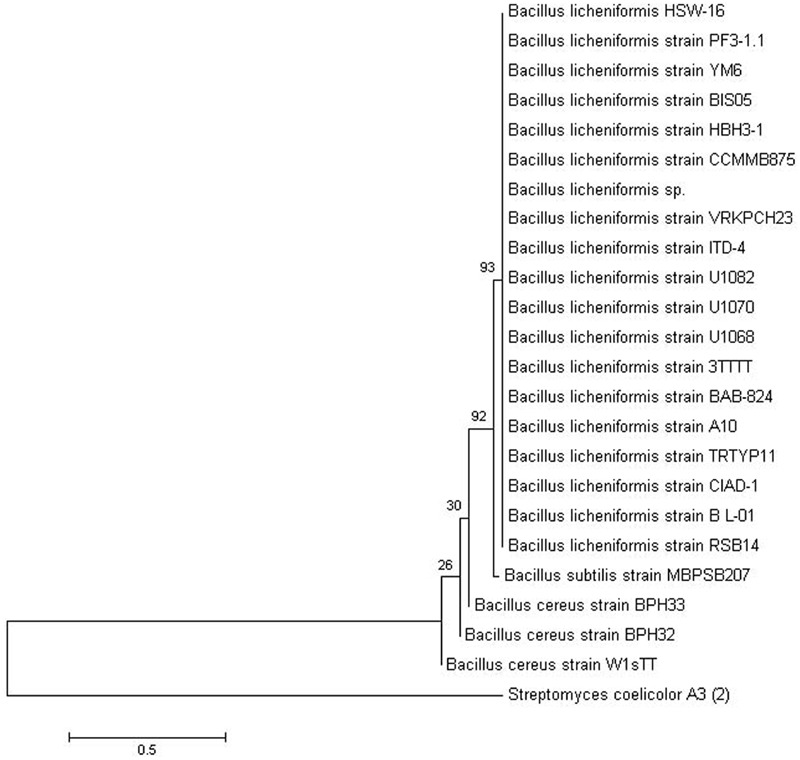
Phylogenetic tree showing the relationship of Bacillus licheniformis HSW-16 to closely related bacteria. The 16S rRNA gene sequence of closely related species was obtained from NCBI GenBank database. 16S rRNA gene of Streptomyces coelicolor A3 was taken as an outgroup. The tree was obtained using neighbor joining method of software package Mega version 6.0 at the bootstrap value of (n = 500).